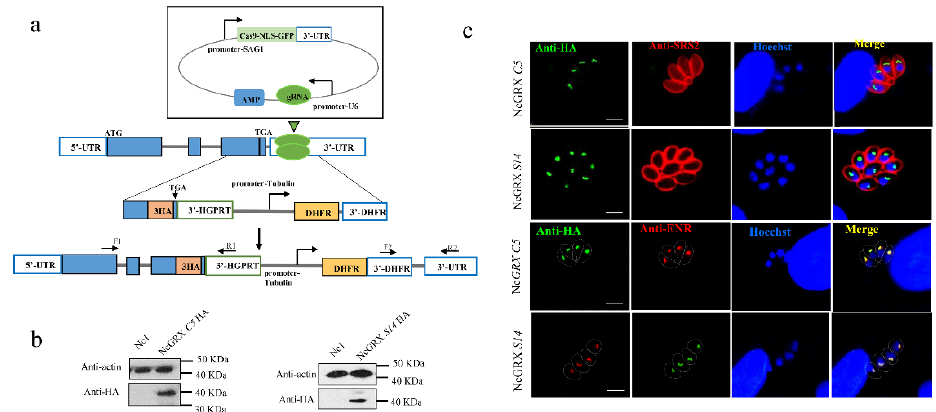
Figure 1. Sequence–structural alignment of the GRX C5 and GRX S14 proteins. ( a ) Alignment of the deduced amino acid sequence of GRX C5 with homologues from other species. The percent homology of GRX C5 with each glutaredoxin is shown at the end of the alignment. Regions of high identity and similarity between glutaredoxin sequences are shown as black and grey columns, respectively. Active site residues are marked with a red letter, and residues involved in interactions with GSH are marked with a green letter. ( b ) Alignment of the deduced amino acid sequence of GRX S14 with homologues from other species. The “*” represent highly conserved amino acid residues.